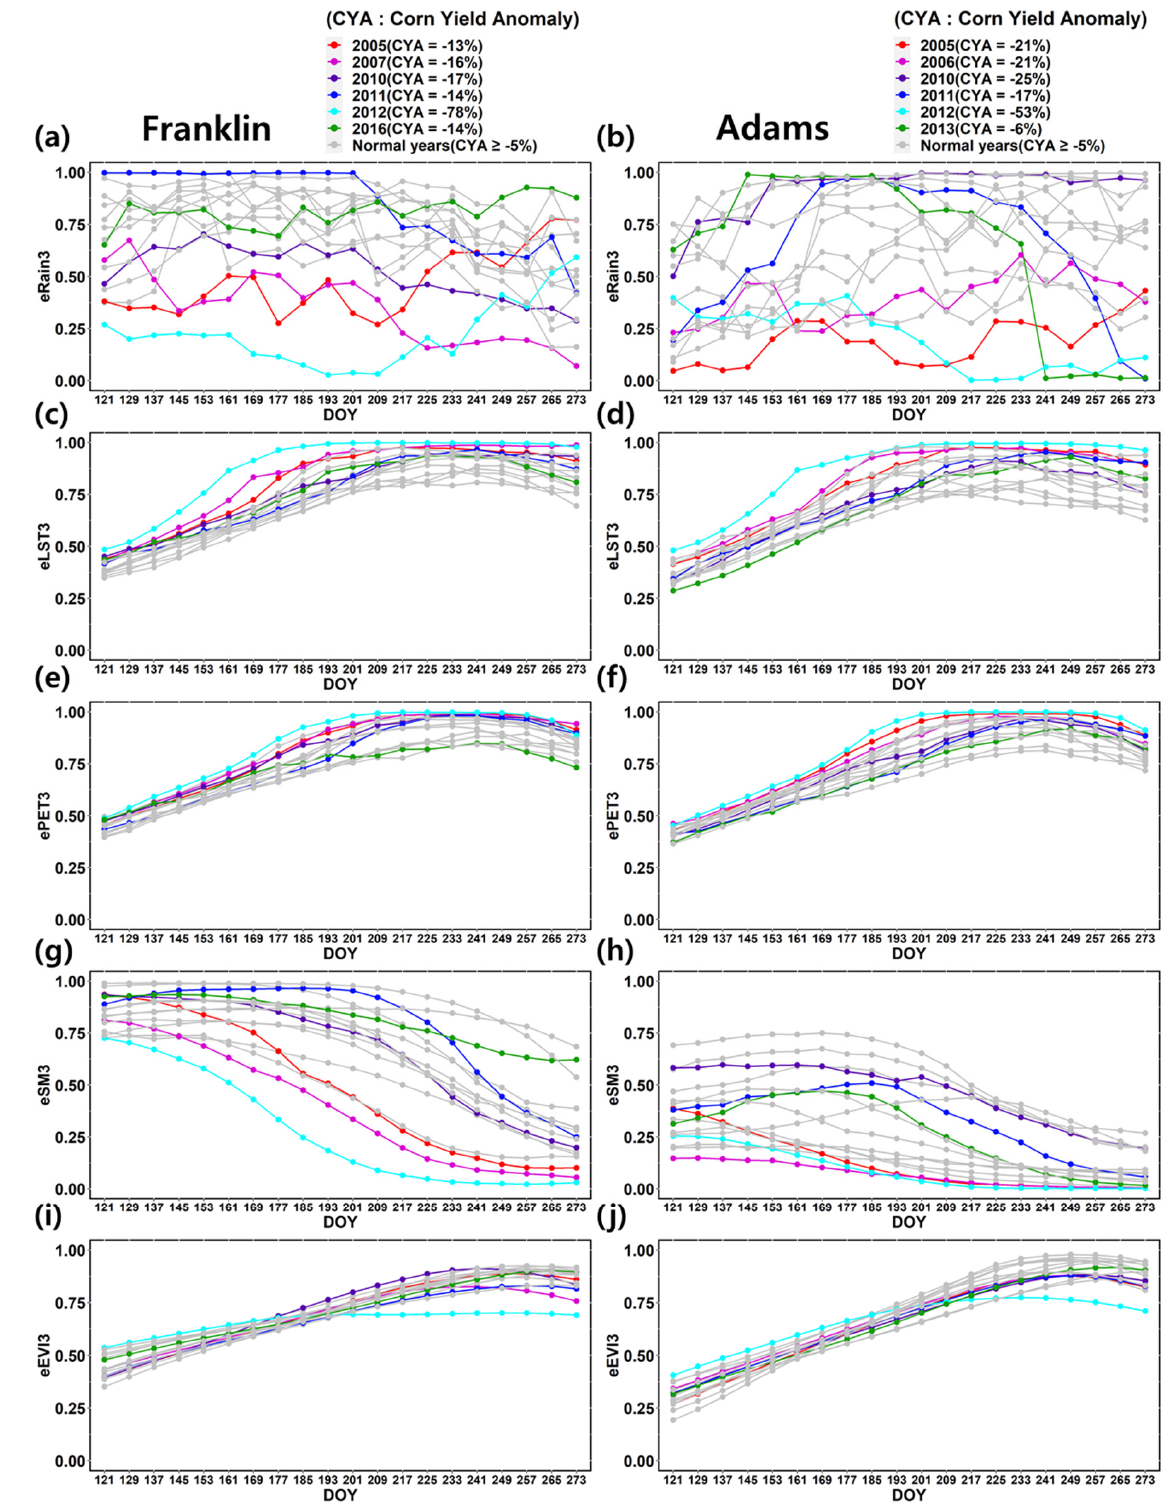
Figure 7. Time-series of eRain3, eLST3, ePET3, eSM3, and eEVI3 in the severely damaged counties: eRain3 in Franklin ( a ) and Adams ( b ); eLST3 in Franklin ( c ) and Adams ( d ); ePET3 in Franklin ( e ) and Adams ( f ); eSM3 in Franklin ( g ) and Adams ( h ); eEVI3 in Franklin ( i ) and Adams ( j ).